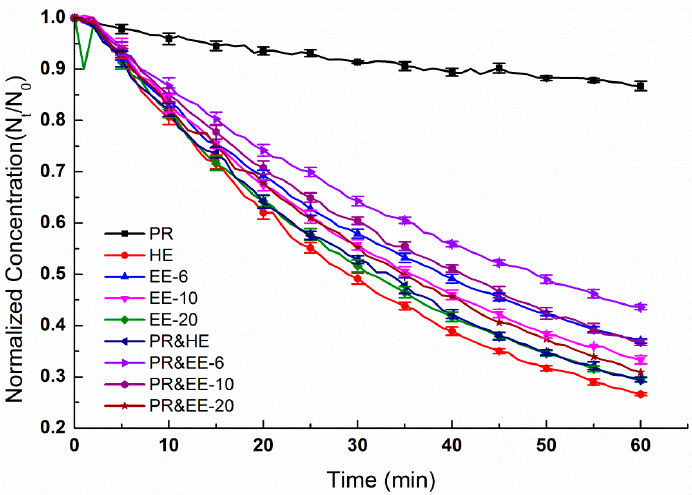
Figure 10. Numeric concentration over time of indoor PM 1.0 with PAC with different filters.